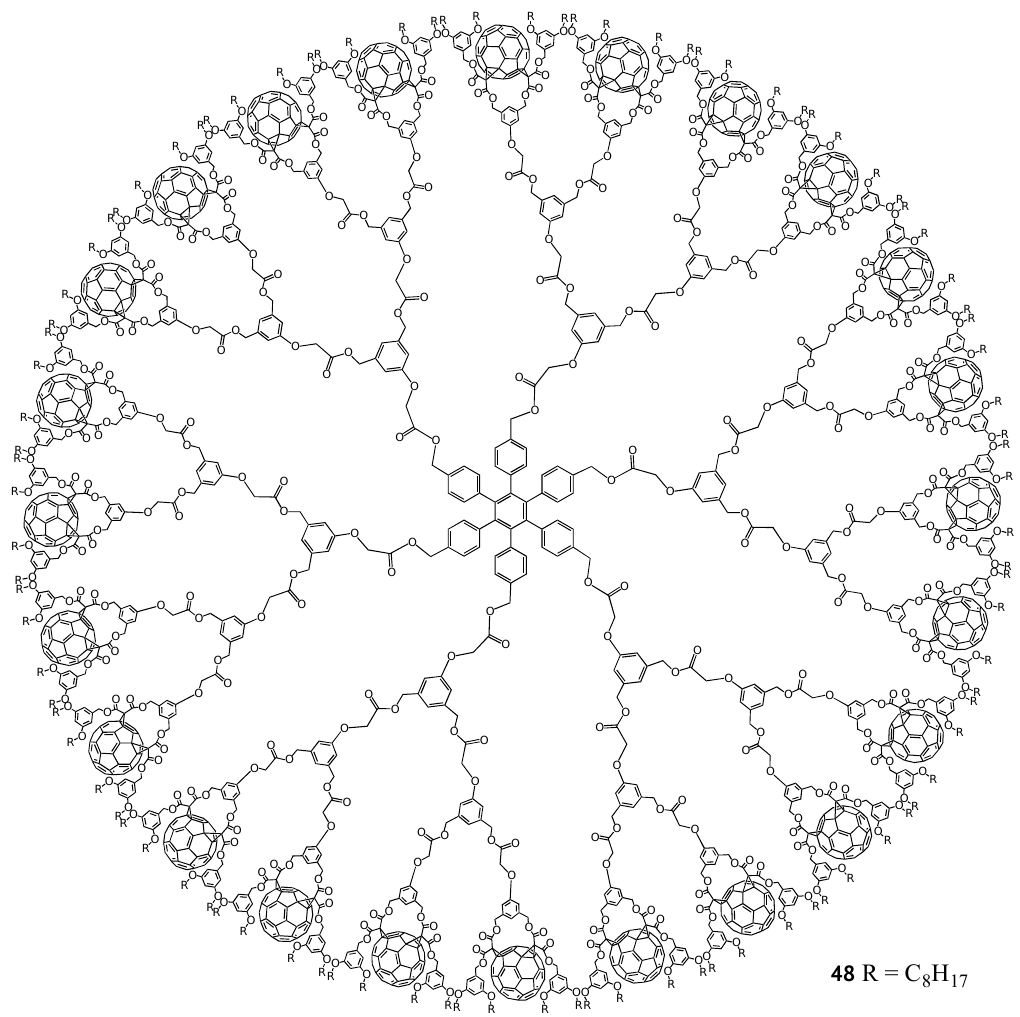
Figure 5. Representative structure of the largest G3 fullerodendrimer 48 deriving from the cyclotrimerisation of dumbbell-shaped bisarylalkyne 45